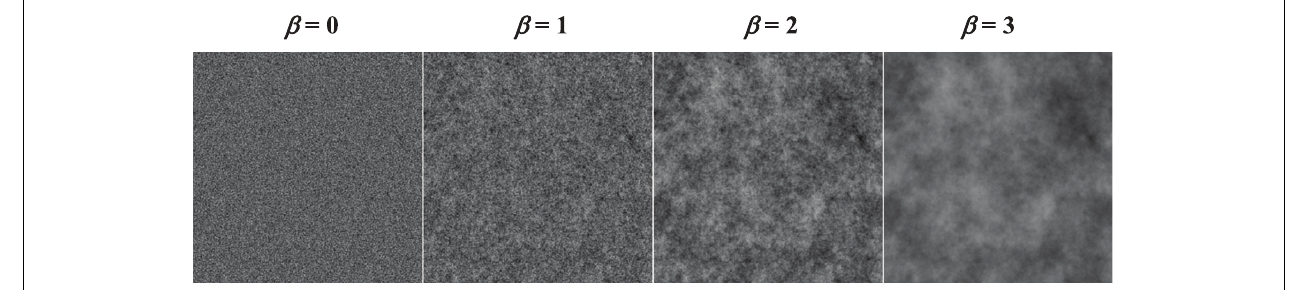
FIGURE 2 | Sample power-law textures. Noisy backgrounds with different power-law exponents ( β ) are shown from the same underlying random number seed.